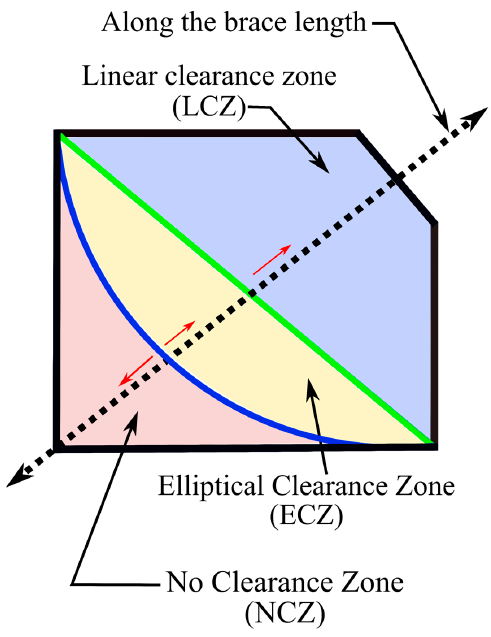
Figure 6. Different clearance zones associated with the gusset plate.